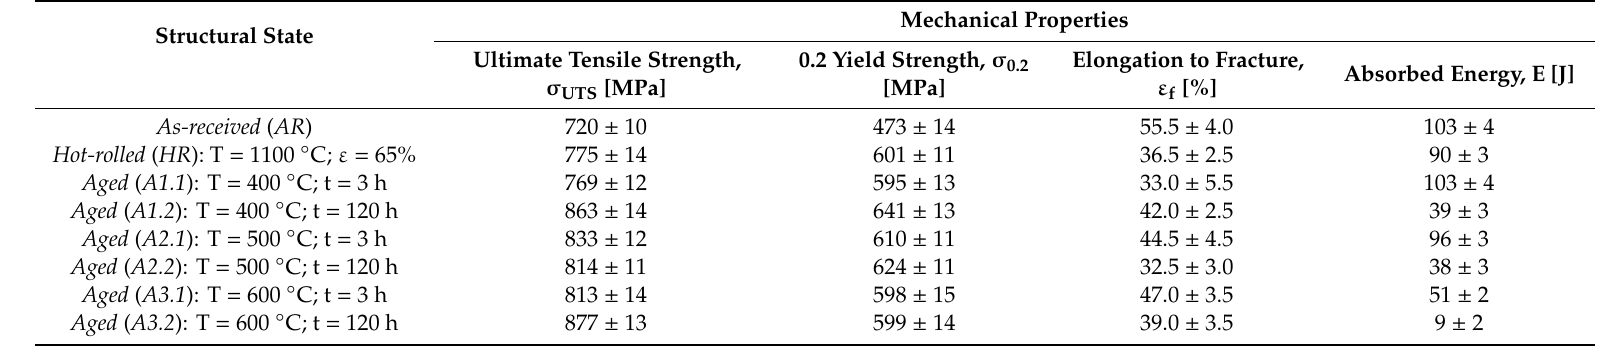
Table 1. Mechanical properties for the thermomechanical (TM) processed UNS S32750 super duplex stainless steel (SDSS)